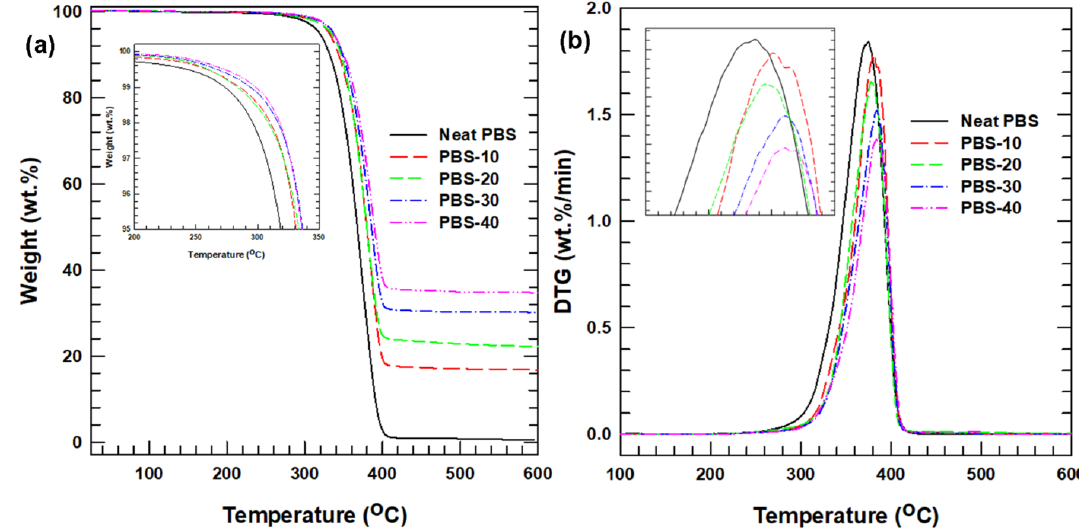
Figure 2. ( a ) TGA thermogram of the neat PBS and the PBS composites; ( b ) derivative of the TGA curve.